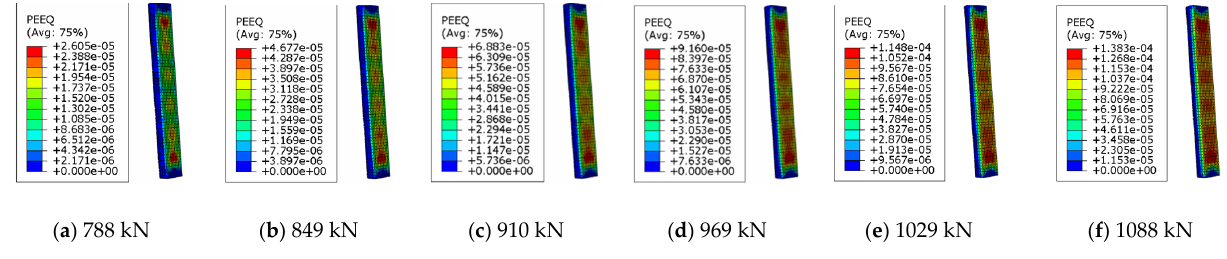
Figure 6. QEET nephograms of CTRC_200_6_25.